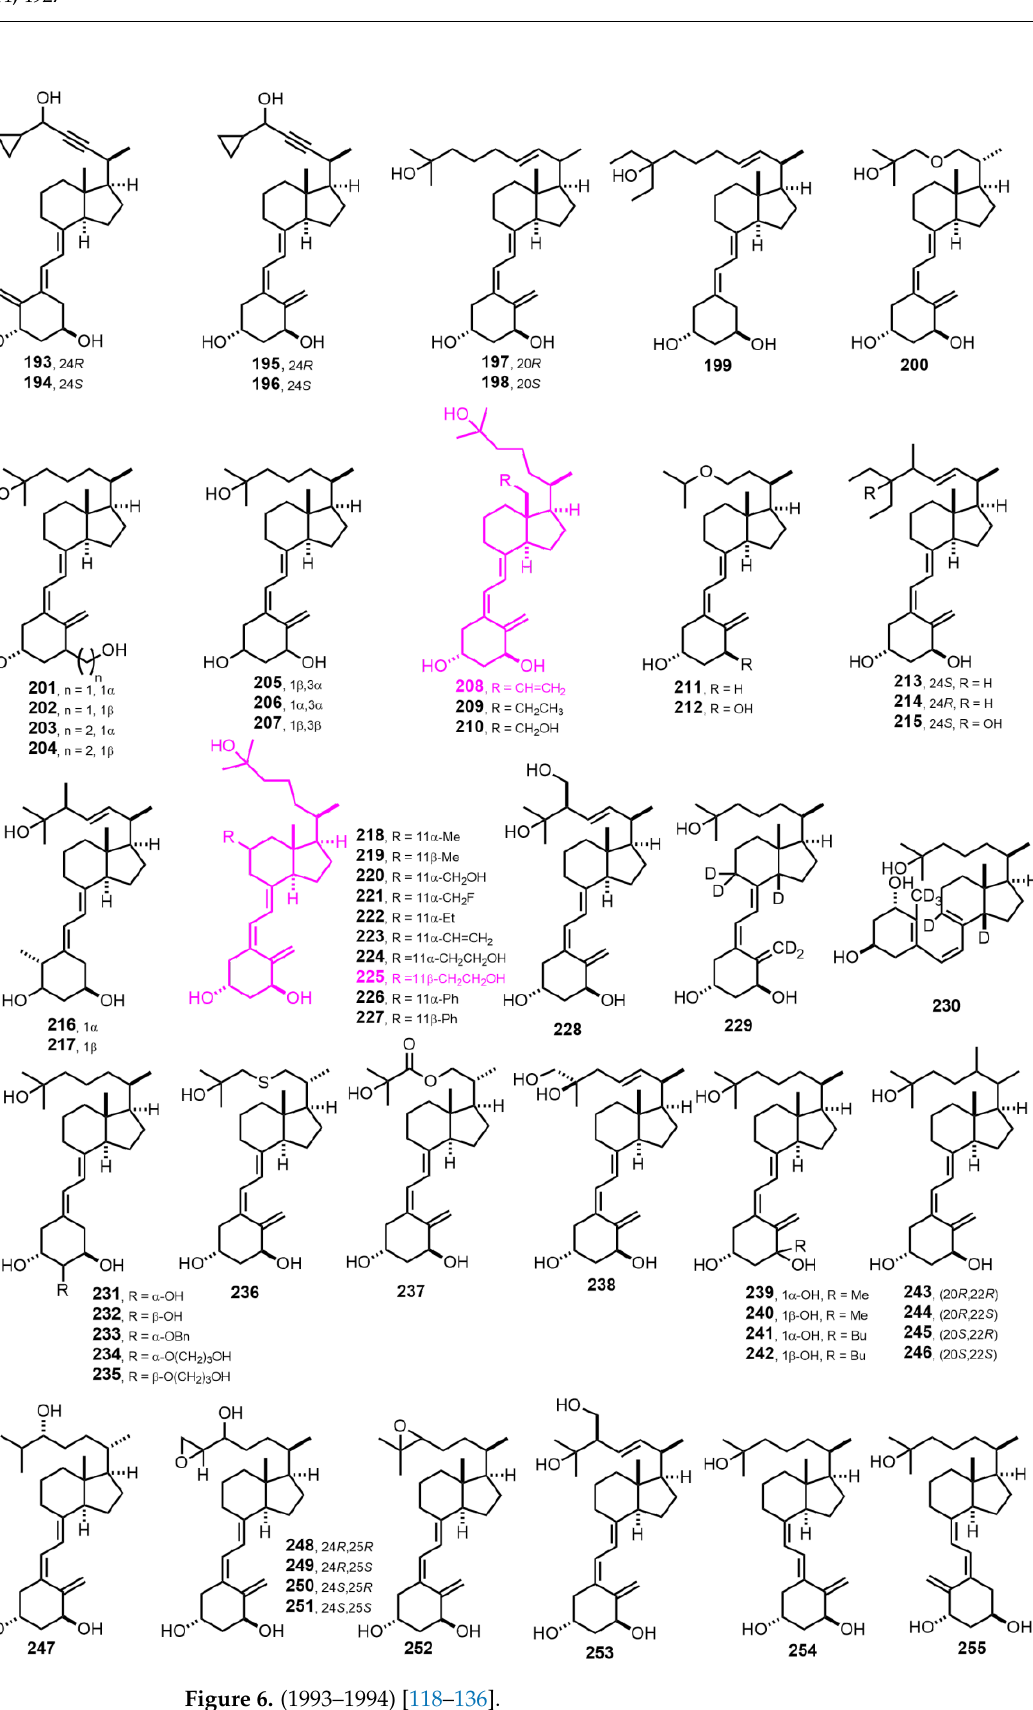
Figure 6. (1993-1994) [118 – 136].